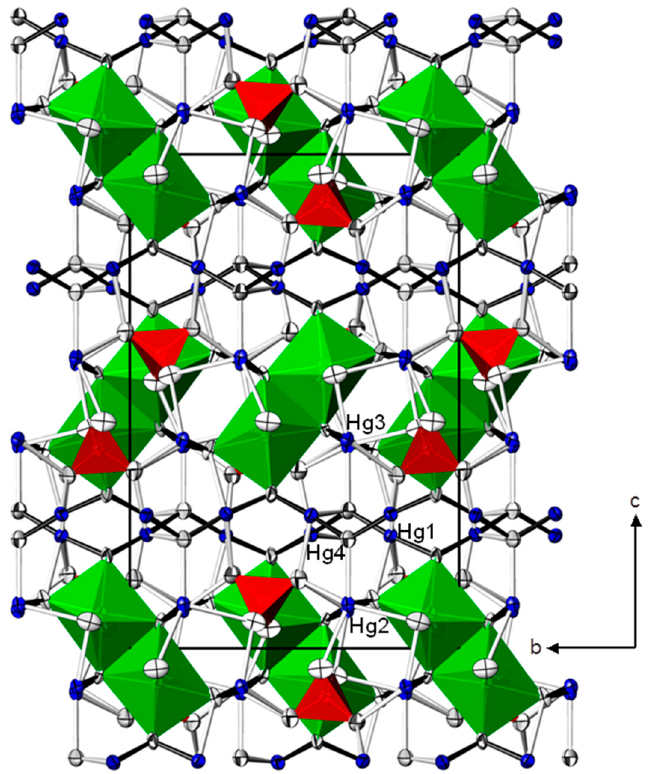
Figure 5. The crystal structure of Cd(Hg II ) 4 O 4 (CrO 4 ). [CrO 4 ] tetrahedra are red, and [CdO 6 ] octahedra are green. Displacement ellipsoids are as in Figure 3.